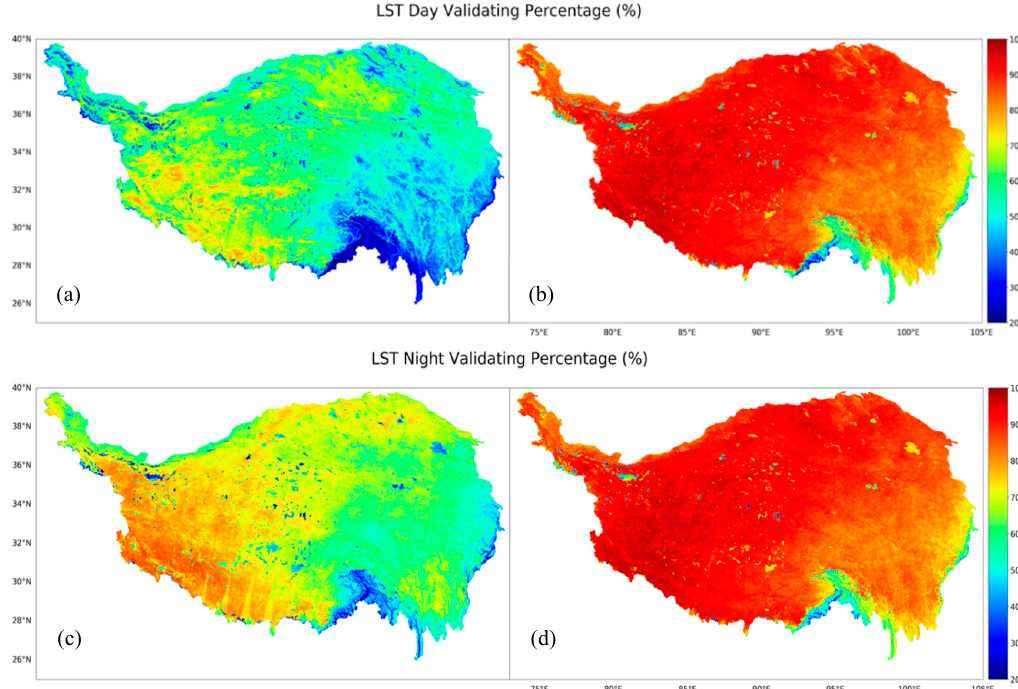
Figure 3. The percentages of available data in the two pairs of maps. ( a ) shows the percentage of days for the given year for which LST day (i.e., 1:30 pm on Aqua (T2)) values are available at each pixel of the TP domain. ( b ) shows the percentage of daily merged T2 for the given year for which daily merged T2 values are available. ( c ) shows the percentage of days for the given year for which LST night (i.e., 1:30 am on Aqua (T4)) values are available at each pixel of the TP domain. ( d ) shows the percentage of daily merged T4 for the given year for which daily merged T4 values are available.